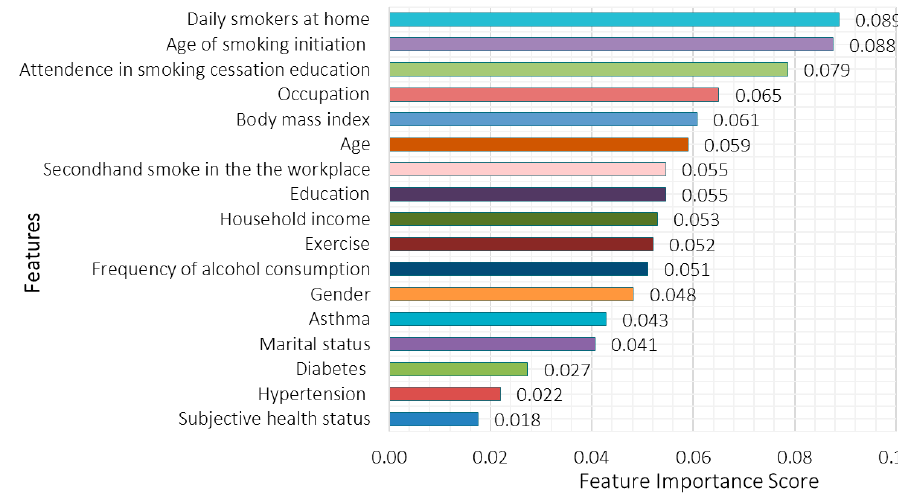
Figure 6. Feature Importance of Synthetic Minority Over-Sampling Technique (SMOTE) with the Gradient Boosting Trees (GBT) model.